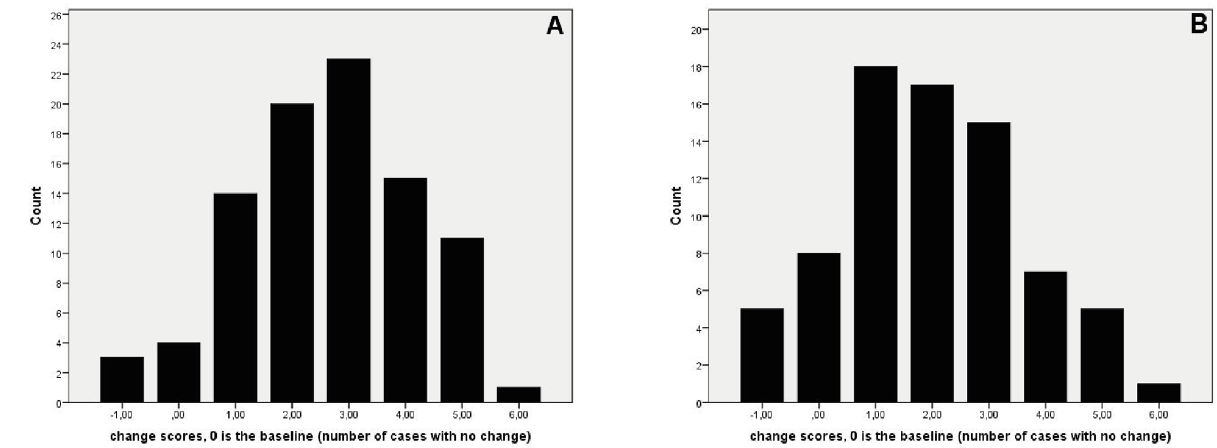
Figure 2. Number of changes in opinions on six statements immediately after (A) and one week after (B) the video interview intervention. The range of possible change scores is -6 to +6. Changes in the negative direction indicate changes towards disagreement and changes in positive direction reflect changes towards agreement. Cases at 0 (.00), four immediately after and one week after, reflect no-changes in opinions on the six statements in comparison to the baseline. A +6 (one case in both figures) reflects change in opinion (from disagree to agree) on all six statements.